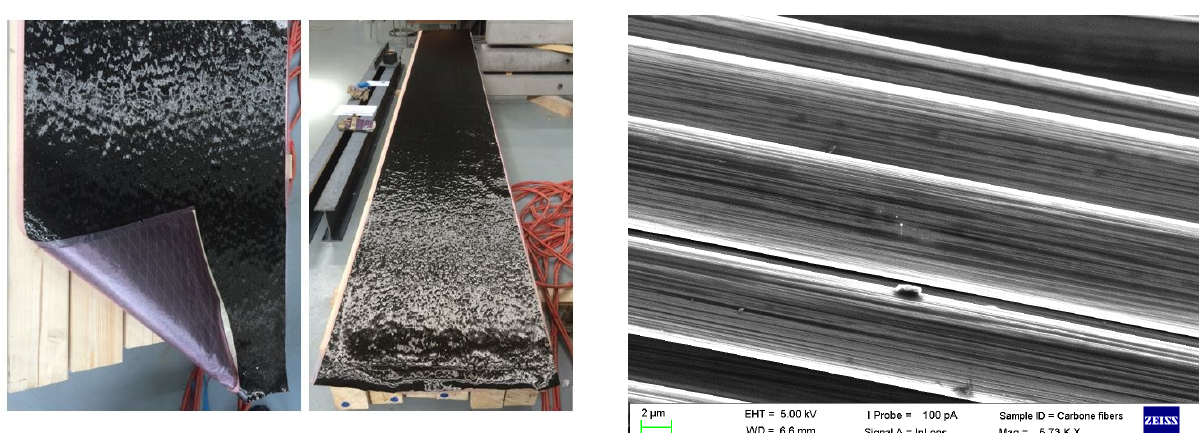
Figure 1. Second set of Glued laminated timber beams.